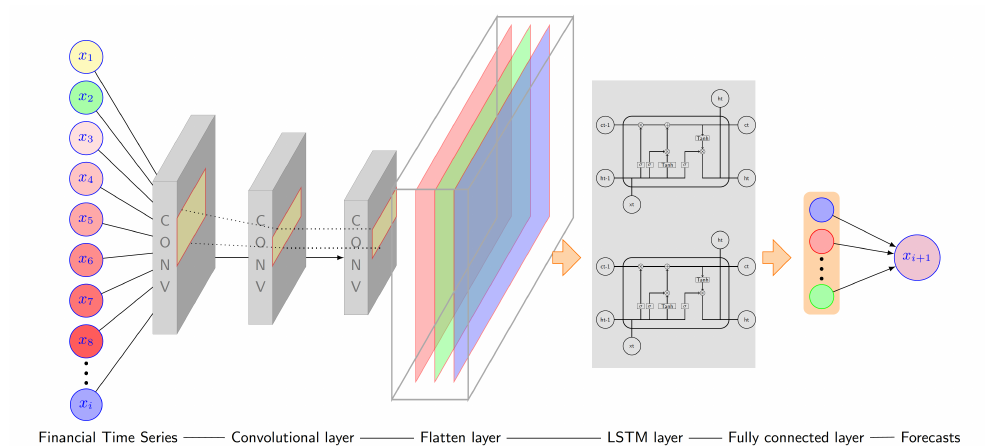
Figure 1. CNN-LSTM network